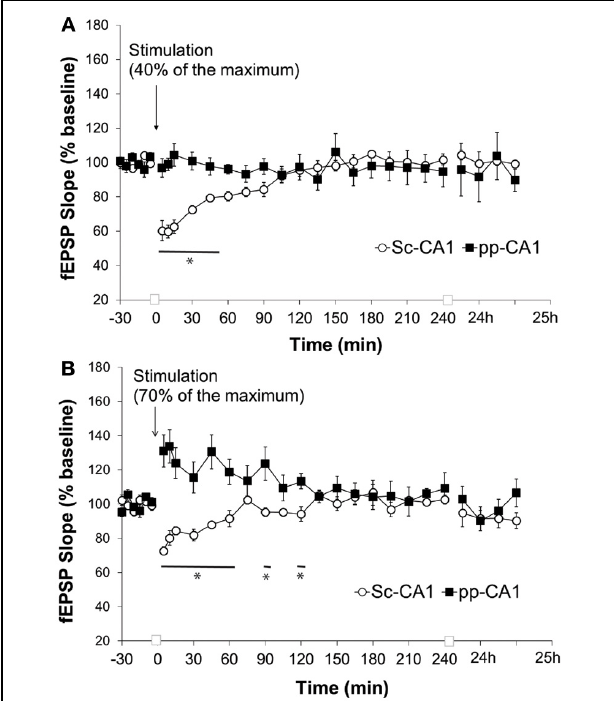
FIGURE 6 | Low frequency stimulation induces short-term depression at the Sc-CA1 synapse irrespective of stimulation intensity but potentiates the pp-CA1 synapse with high-intensity. (A) Low frequency stimulation (LFS, 1Hz, 600 pulses) with low-intensity stimulation (to evoke 40% of the maximum evoked response) did not have any effect at the pp-CA1 synapse in freely behaving rats, whereas short-term depression was elicited at SC-CA1 synapses. Sc-CA1 depression was significant compared to evoked potentials at pp_CA1 synapses (ANOVA). The line with the asterisk indicates individual time-points in SC-CA1 responses that were determined to be significant from the pp-CA1 responses, using post-hoc Fisher’s LSD test. (B) LFS (1Hz, 600 pulses) with high-intensity stimulation (to evoke 70% of the maximum evoked response) resulted in potentiation at the pp-CA1 synapse in freely behaving rats and short-term depression in the Sc-CA1 synapses. The lines marked with asterisks indicate individual time-points in SC-CA1 responses that were determined to be significant from the pp-CA1 responses, using post-hoc Fisher’s LSD test.